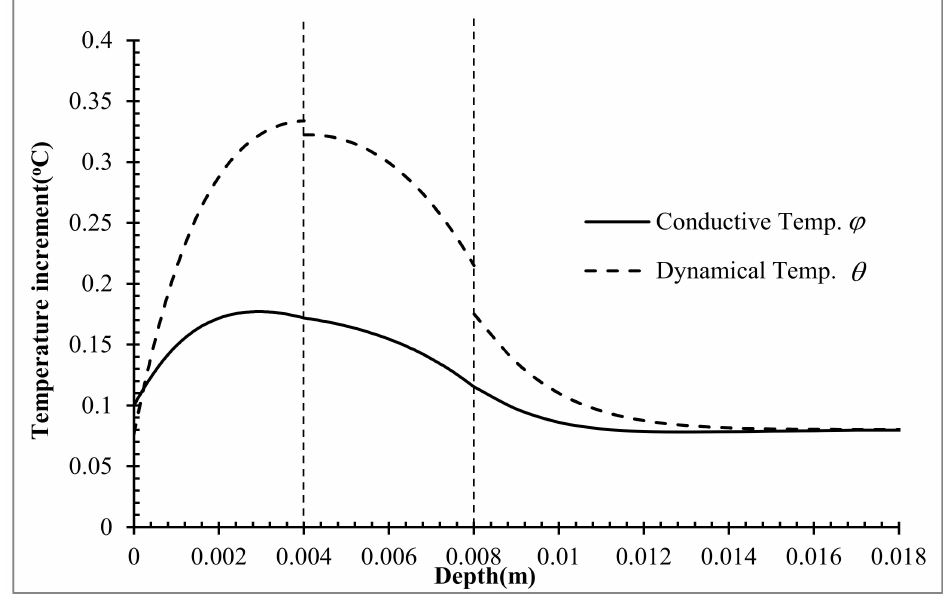
Figure 2. The conductive and dynamical temperature increment on an adult’s head.